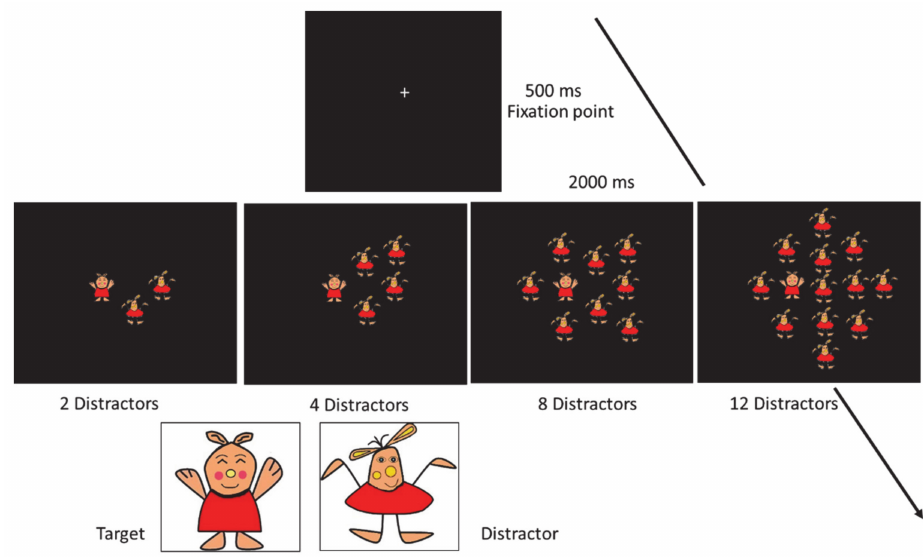
Figure 1. Schematic representation of the serial visual search task with the four possible distractor set-sizes (target present condition is reported). Target and distractor stimuli are also